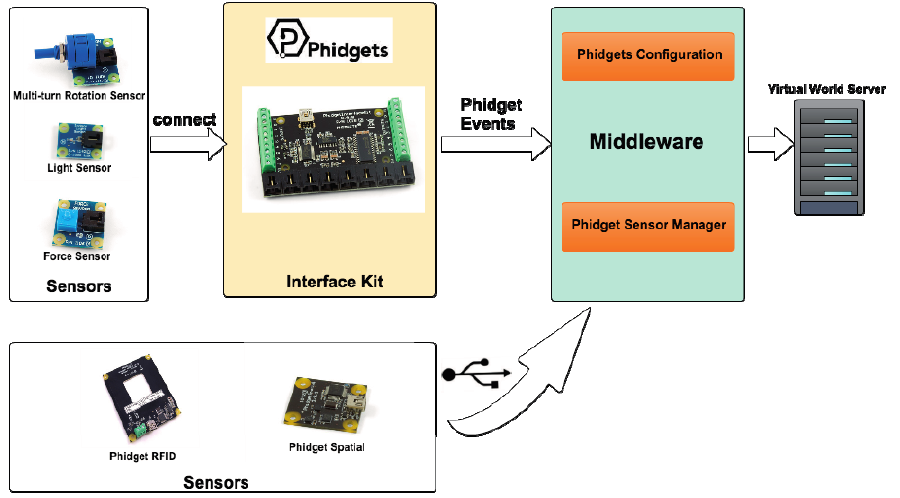
Figure 3. Hardware architecture for the Phidgets